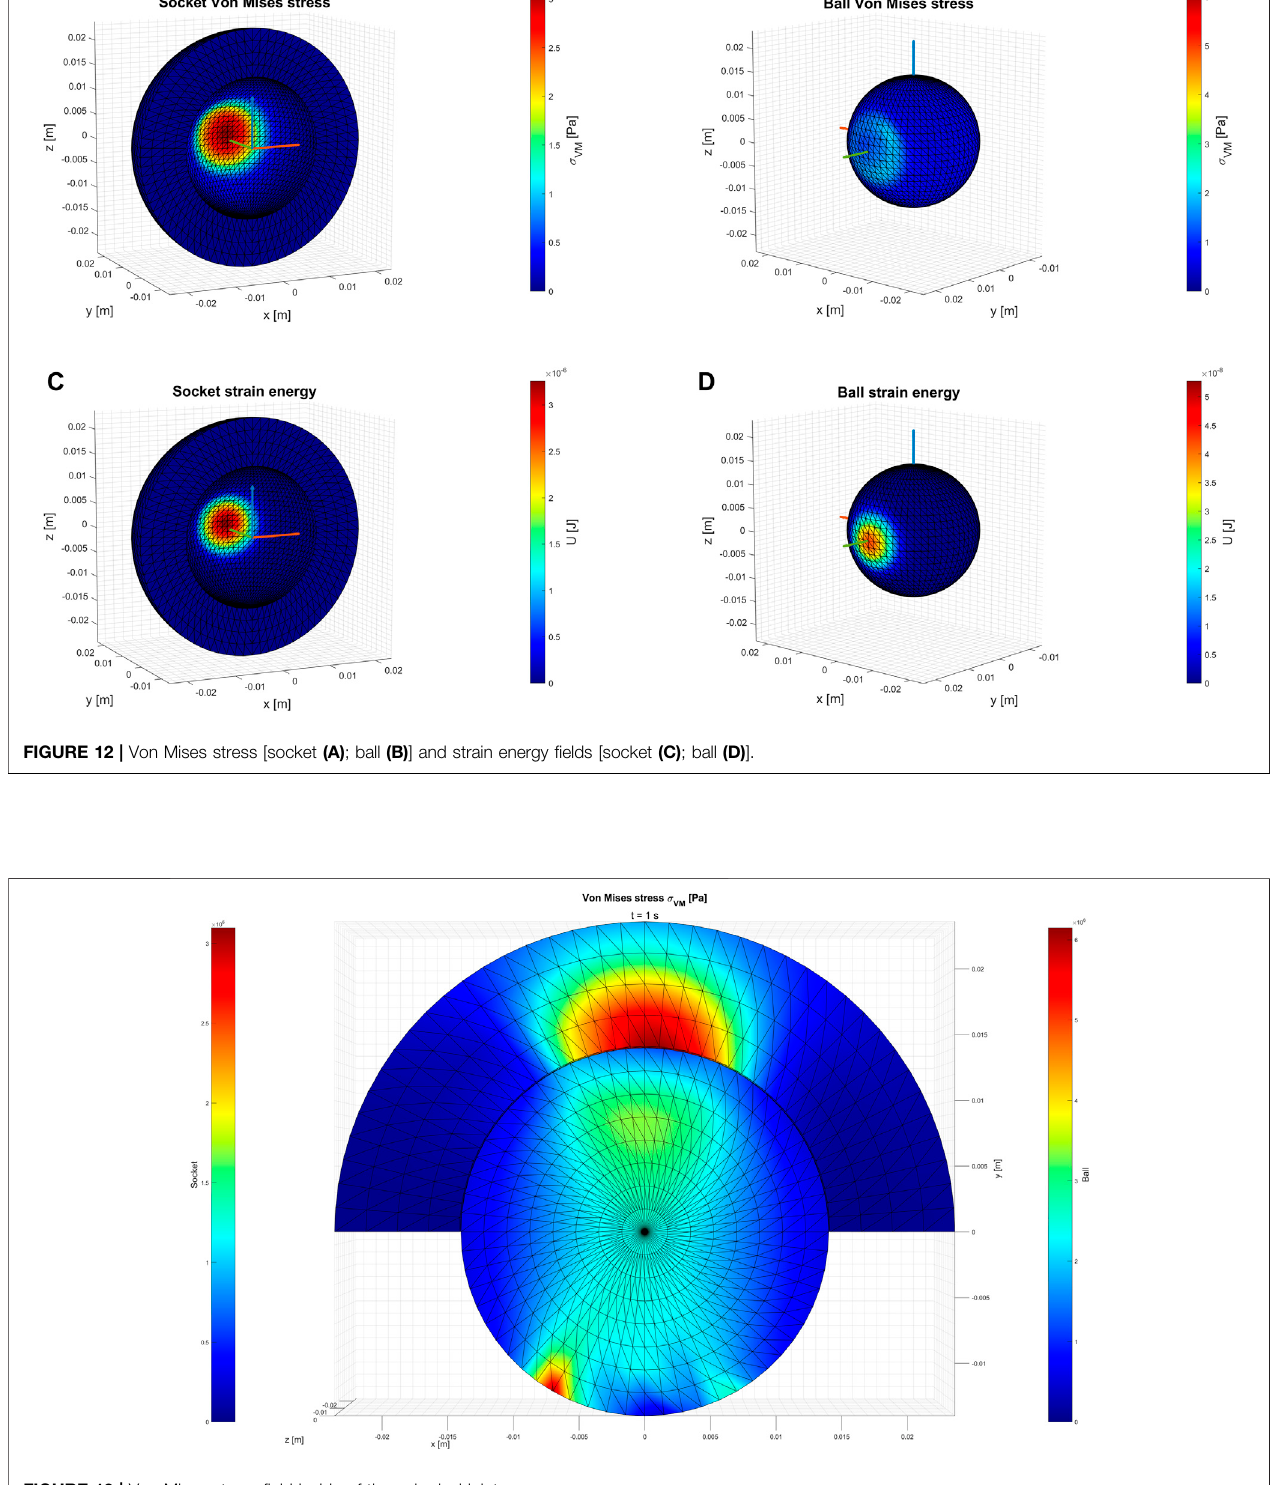
Frontiers in Mechanical Engineering |